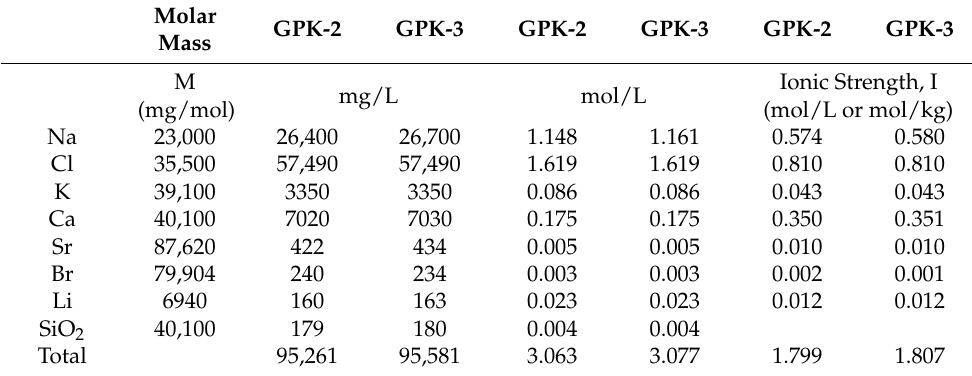
Figure 6. Schematic plot showing the general applicability of different activity coefficient models as a function of ionic strength for a divalent cation. The dashed tangent to the curve at its origin is a plot of the Debye–Hückel limiting law for the ion [18]. Table 7. Ionic strength calculations of the geothermal fluid sampled at GPK-2 and